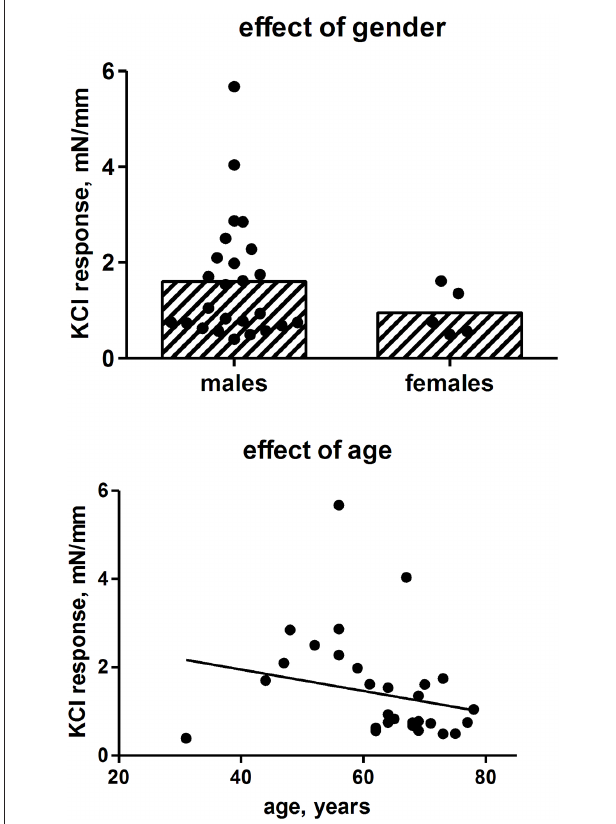
Figure 3 | effect of gender and age on contractile responses to 50 mM KCl. Each data point represents one patient (25 males, 5 females, 1–6 strips per patient), whereas the bars in the upper panel represent the group means.